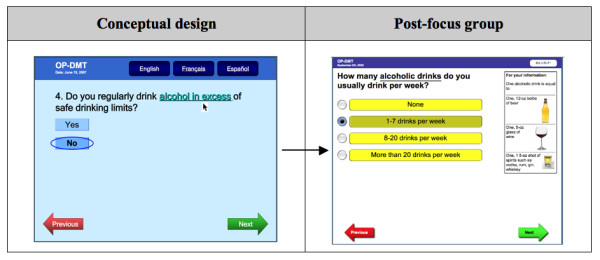
RAQ question about alcohol consumption.